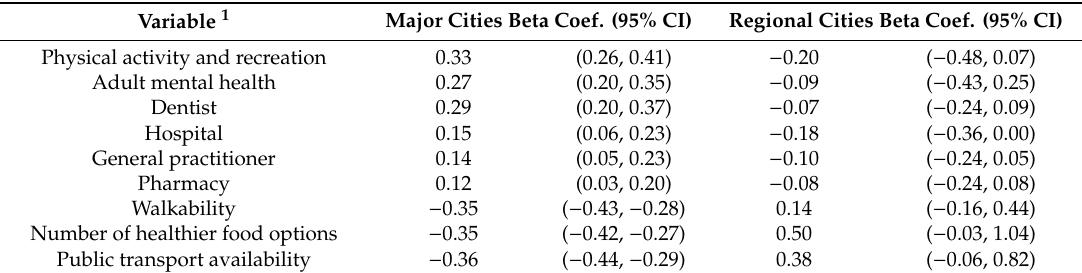
Table 3. Associations between built environment indicators (z-standardized variables) and SA2 disability prevalence for people aged 15–64 years, stratified by city